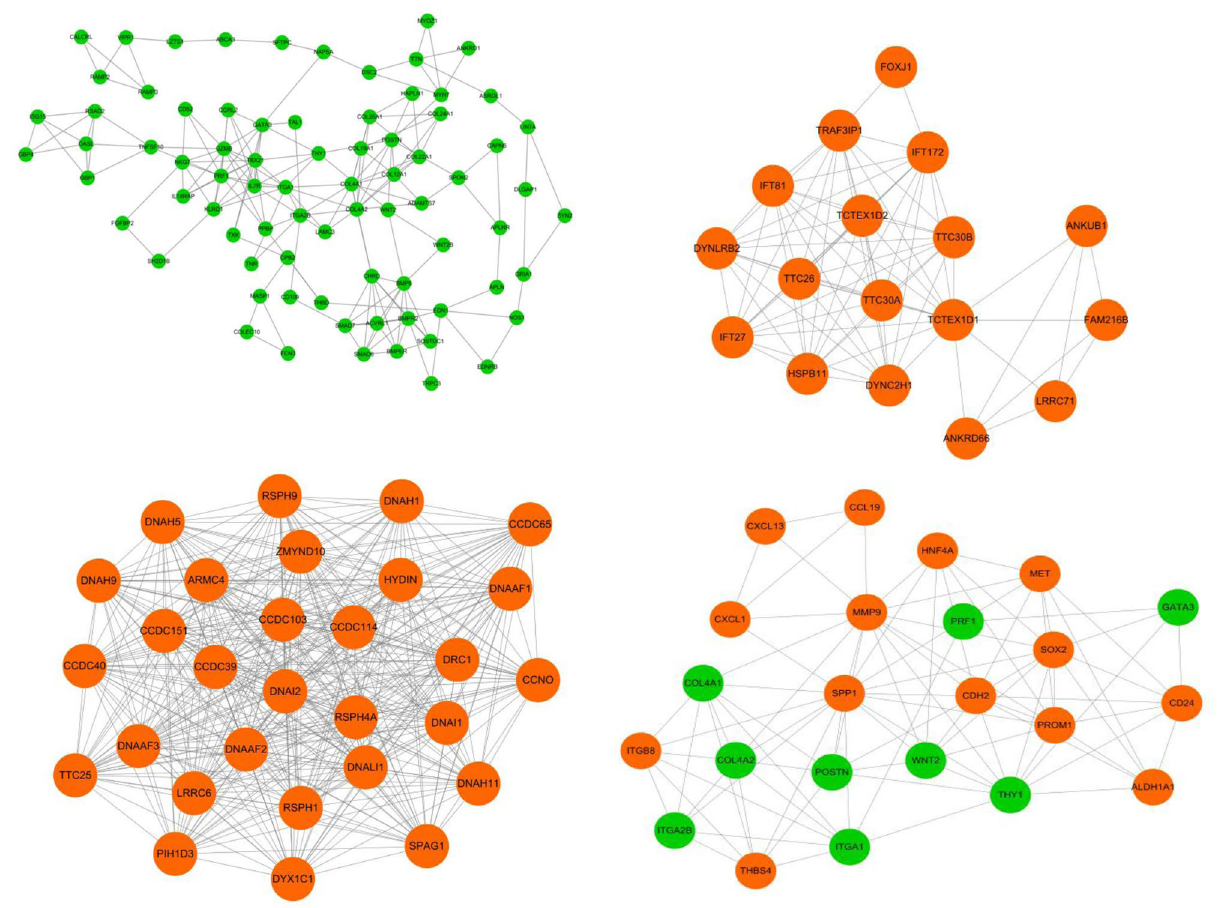
Figure 4. PPI network for DEGs in CPAM. Genes in orange circles indicate upregulation, while genes in green circles indicate